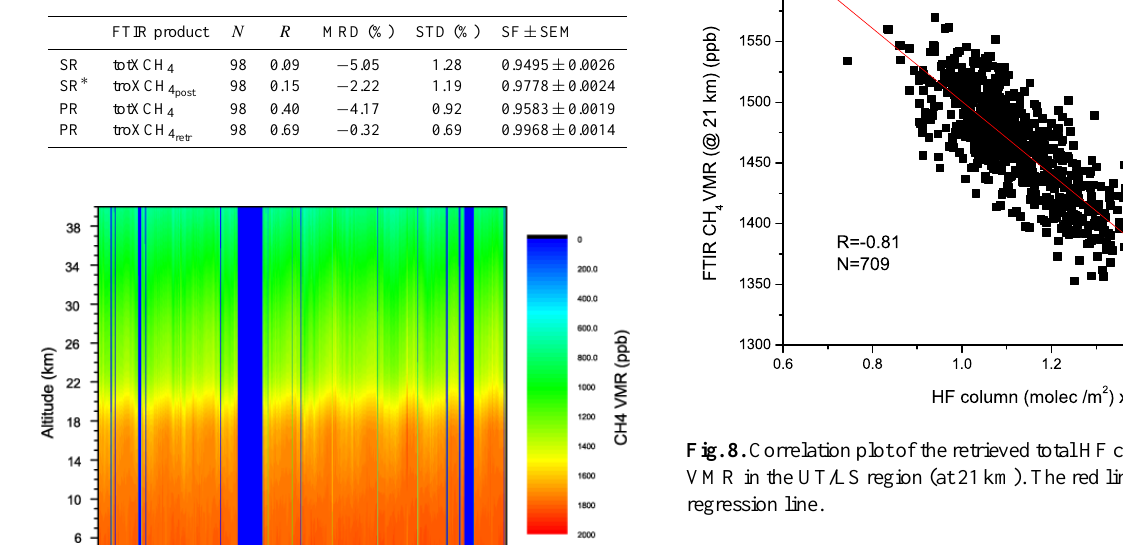
Table 7. Same as Table 6 but for monthly means.